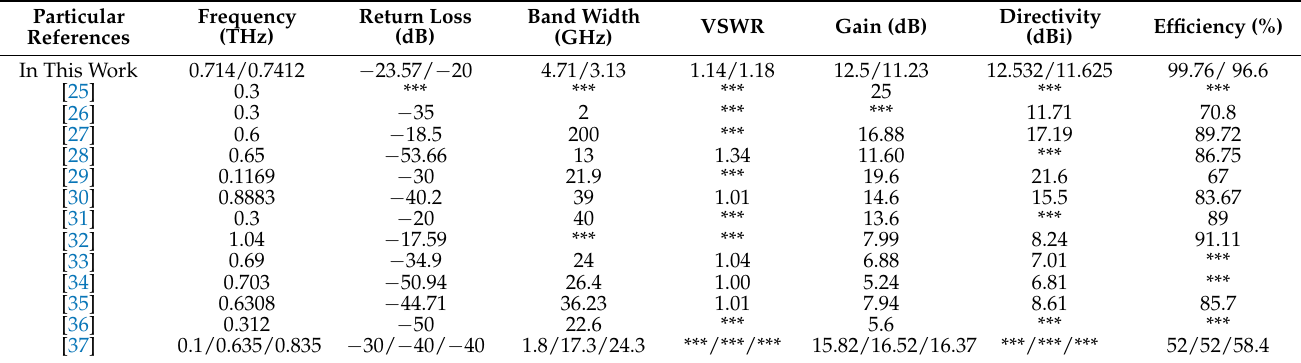
Table 1. Comparison of dual-band THz antenna array with past reported